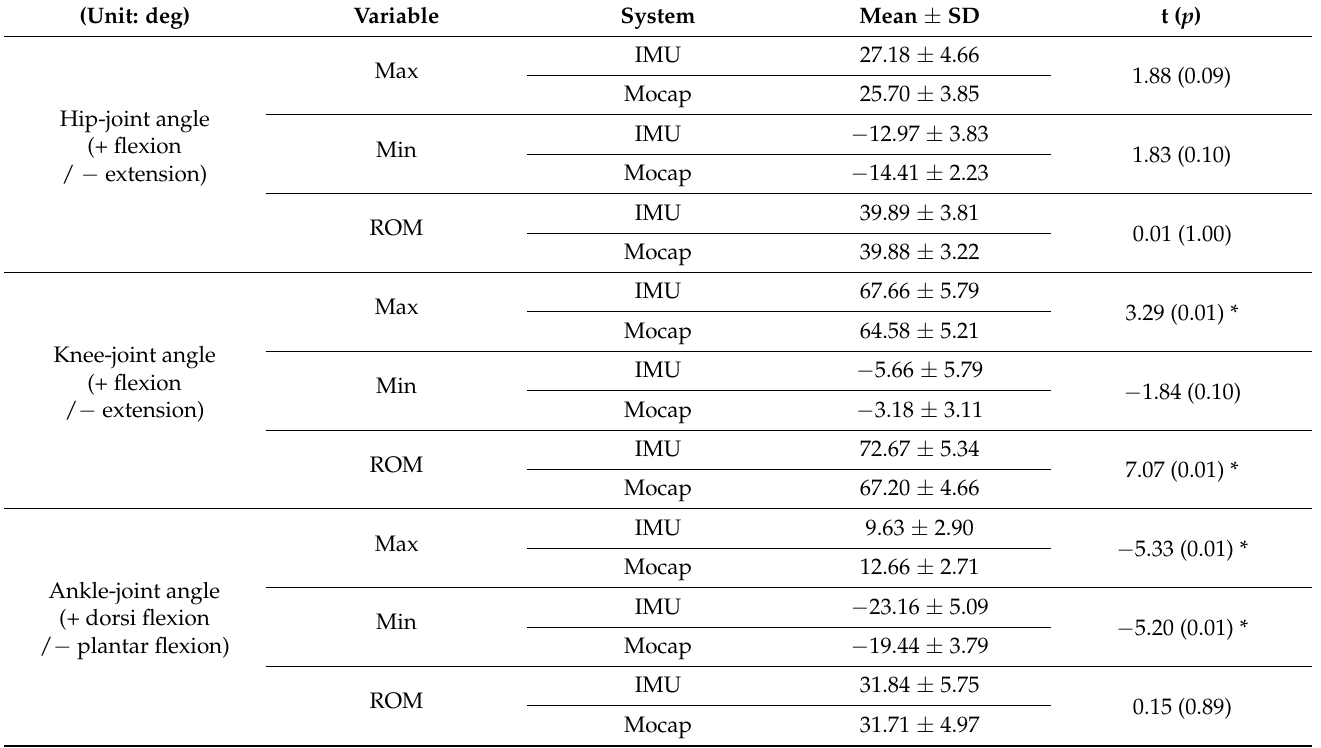
Table 1. Comparison of lower-extremity joint angles between the IMU and Mocap